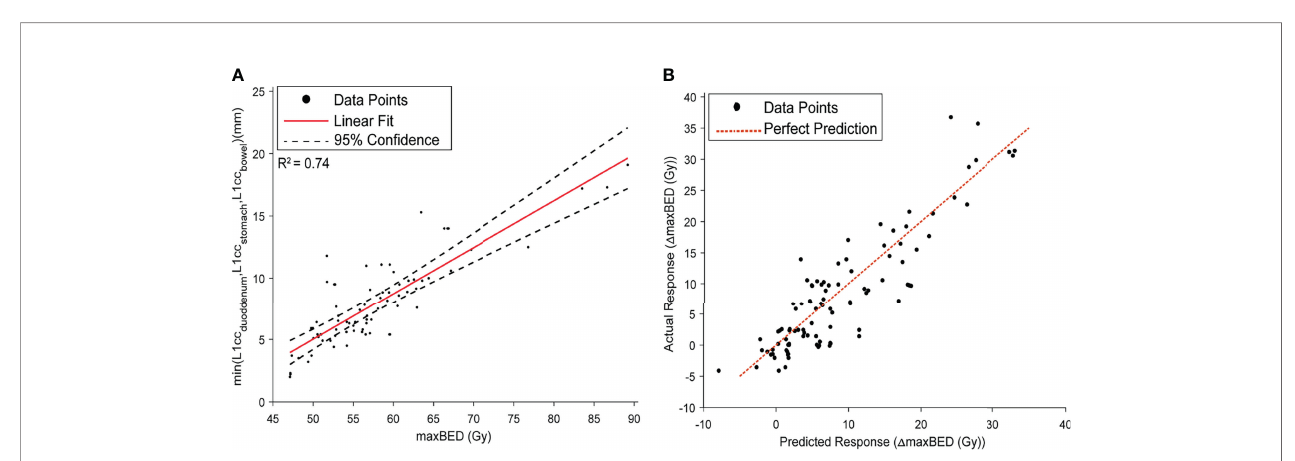
FIGURE 7 | (A) the Linear model fi t between maxBED and minL 1 CC . A high correlation was found between the two variables. (B) The prediction performance curve for the Bayesian model, predicting the D maxBED